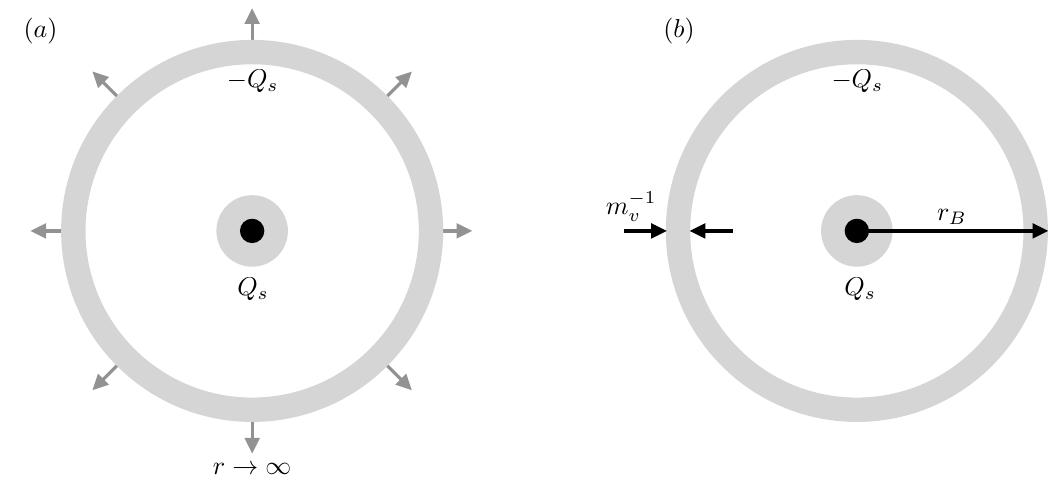
Figure 5 . Schematic description of how the Higgs mechanism operates, at the classical level, in the case of in(cid:12)nite-sized ( a ) and (cid:12)nite-sized ( b ) systems. A spherical distribution of charge Q s is generated at the centre of the cavity (inner grey region) that screens the charge of the BH. Conservation of charge requires the presence of an equal but opposite charge distribution. In a system of in(cid:12)nite size, this compensating charge is sent all the way to spatial in(cid:12)nity. Within a (cid:12)nite-sized cavity, it can only be located as far as the cavity wall, distributing itself within a region of thickness m (cid:0) 1 (outer grey v